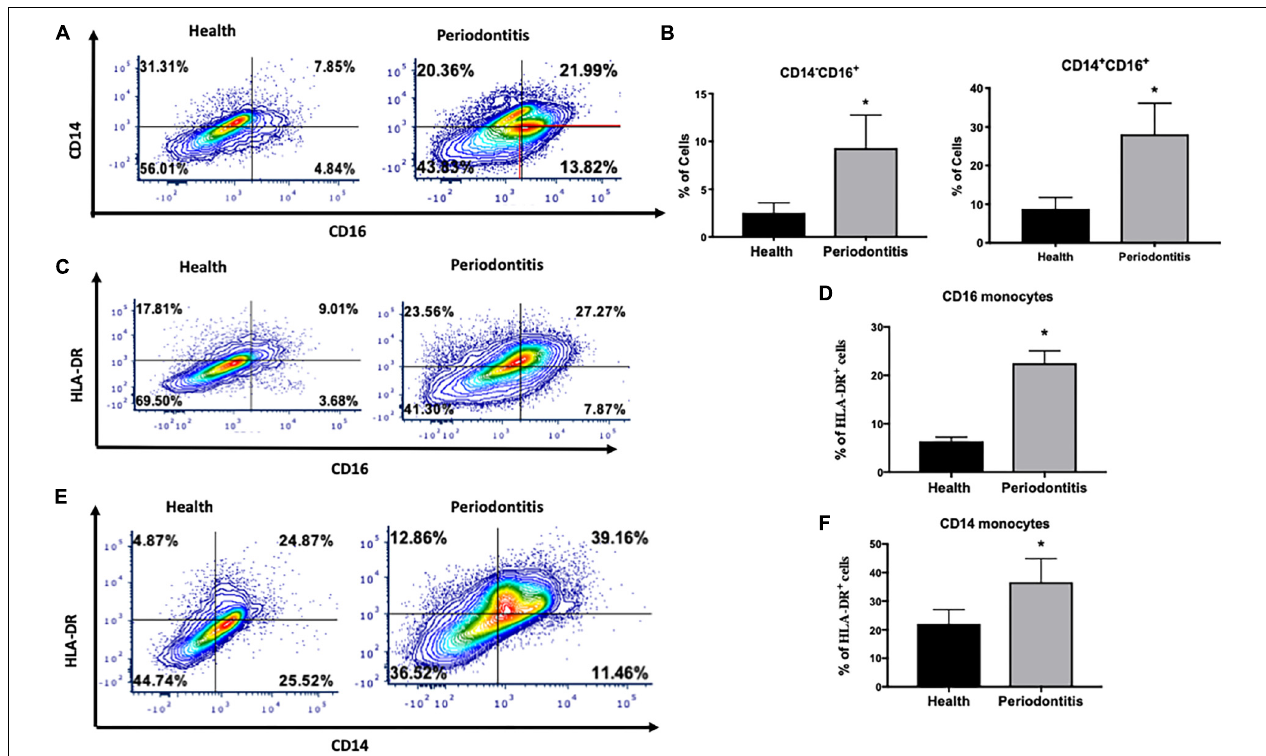
FIGURE 1 | Single cell suspensions from matched periodontitis-affected and healthy gingival tissues were prepared and stained for UV Zombie, CD45, Lin (B220, CD19, Gr1, and Ter119), HLA-DR, CD16, CD14. (A,B) Representative counter plots of intermediate (CD14 + CD16 + ) and non-classical monocytes (CD14 − CD16 + ). Frequency of both cell types was higher in periodontitis-affected tissue compared to matched controls ( n = 21; p < 0.05). (C,D) Representative counter plots and frequency of HLA-DR cells which are gated from live, CD45 + Lin − CD16 + cells in periodontitis-affected gingival tissue and healthy gingival tissue ( n = 21). Frequency of CD45 + Lin − CD16 + HLA-DR + cells was significantly higher in periodontitis-affected tissue compared to health ( p < 0.05). (E,F) Representative counter plots (values indicate percentage of parent population) and frequency of HLA-DR cells which are gated from live, CD45 + Lin − CD14 + cells in the periodontitis-affected gingival tissue and healthy gingival tissue ( n = 21). Frequency of CD45 + Lin − CD14 + HLA-DR + cells was significantly higher in periodontitis-affected tissue compared to health ( p < 0.05). Data presented as mean ± SEM and p less than 0.05 was defined as significant (the symbol “*” indicates p < 0.05 compared to the